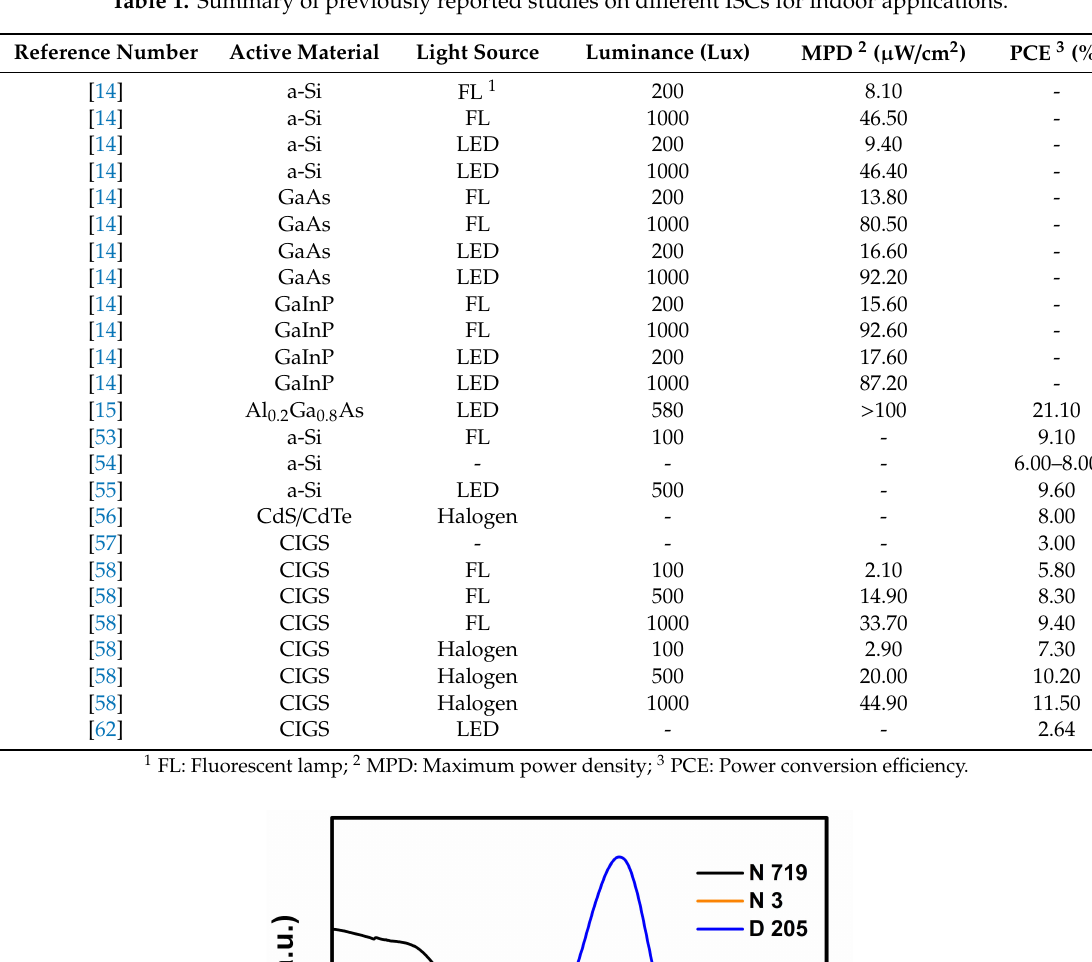
Table 1. Summary of previously reported studies on di ff erent ISCs for indoor applications.